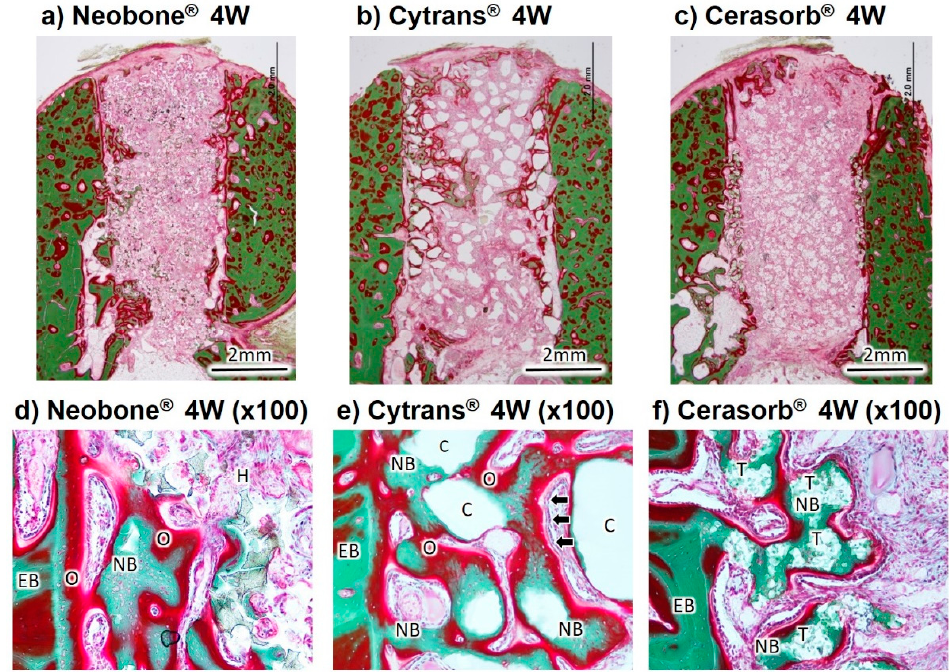
Figure 6. Histological findings of Neobone ® (HAp), Cytrans ® (CO 3 Ap), and Cerasorb ® ( β -TCP) implanted into dog mandibular bone defect at 4 weeks after implantation (Villanueva Goldner staining). Green area, bone; red area, osteoid. Arrows indicate aligned cuboidal osteoblasts around the abundantly formed osteoid on the surface of the new bone. EB, existing bone; NB, new bone; O, osteoid; H, HAp (Neobone ® ); C, CO 3 Ap (Cytrans ® ); T, β -TCP (Cerasorb ® ).